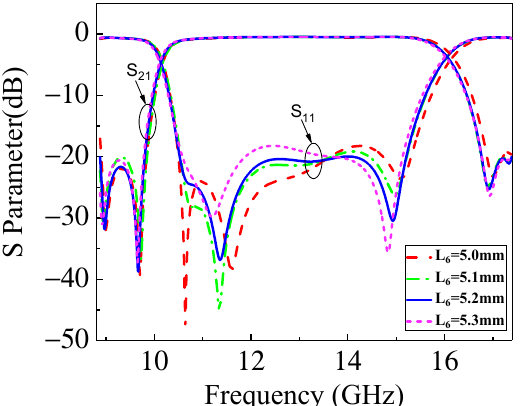
Figure 5. Simulation of S parameters when length L 6 of the wider side of the second coupling patch is varied from 5 mm to 5.3 mm, with a step of 0.1 mm increment. In Figure 6, the effects of width W 2 of U-shaped microstrip line of top coupling patch